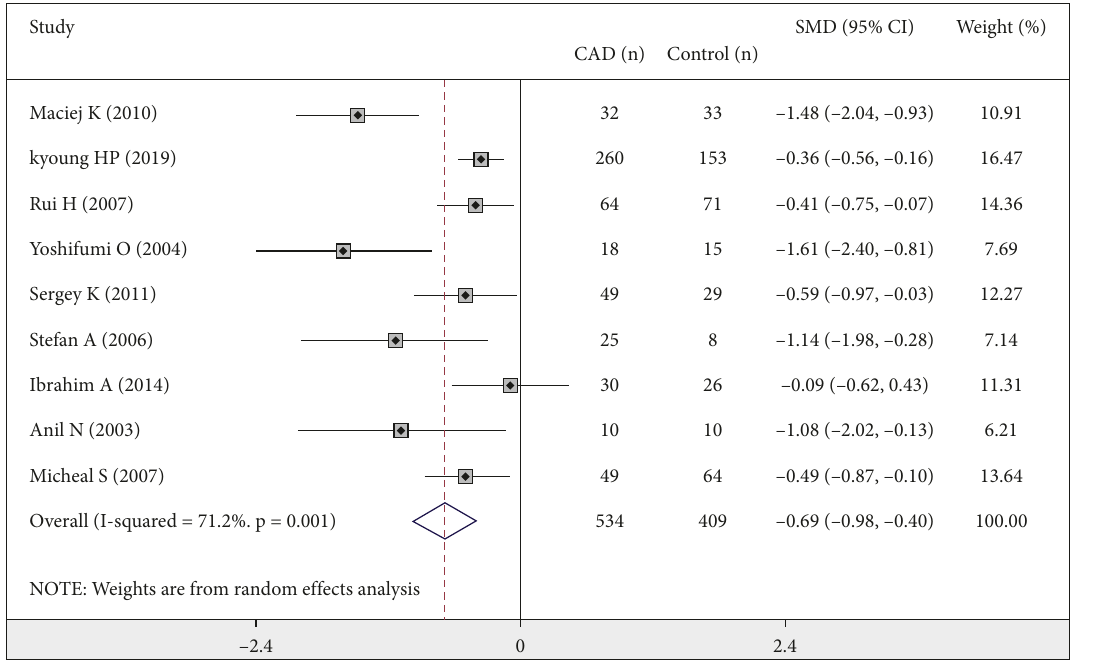
Figure 2: SMD with 95 % CI of FMD in CHD and